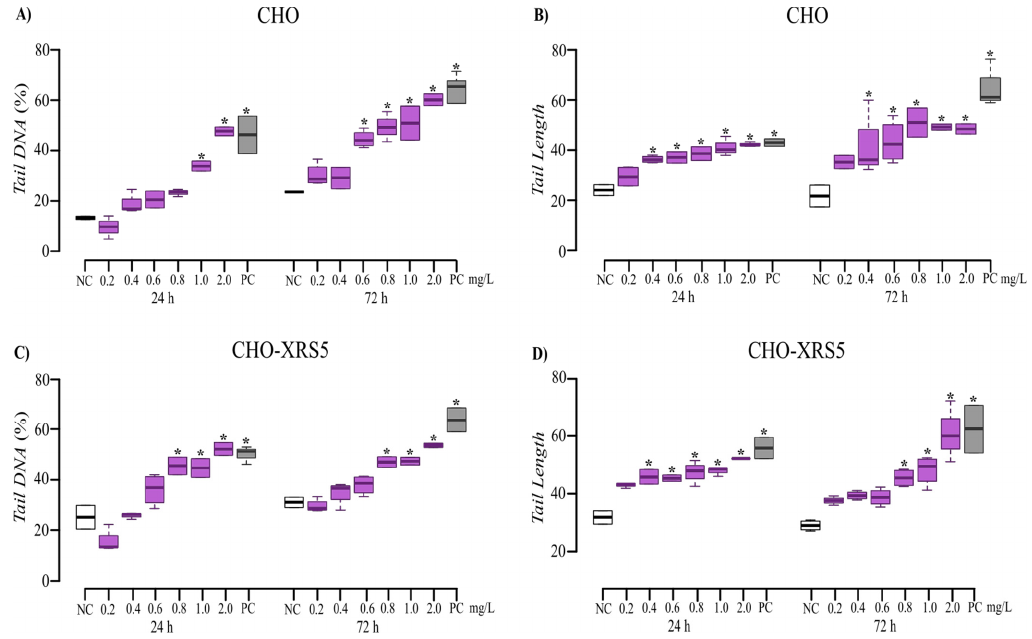
Figure 4. Tail DNA ( A , C ) and Tail Length ( B , D ) measured in CHO ( A , B ) and CHO-XRS5 ( C , D ) exposed to aluminum (violet) for 24 and 72 h. The values are expressed as medians and interquartile deviations of two independent experiments. * p < 0.05 compared to the NC by the Kruskal–Wallis test followed by Dunn’s test. NC, negative control (white); PC, positive control (mitomycin C; gray).